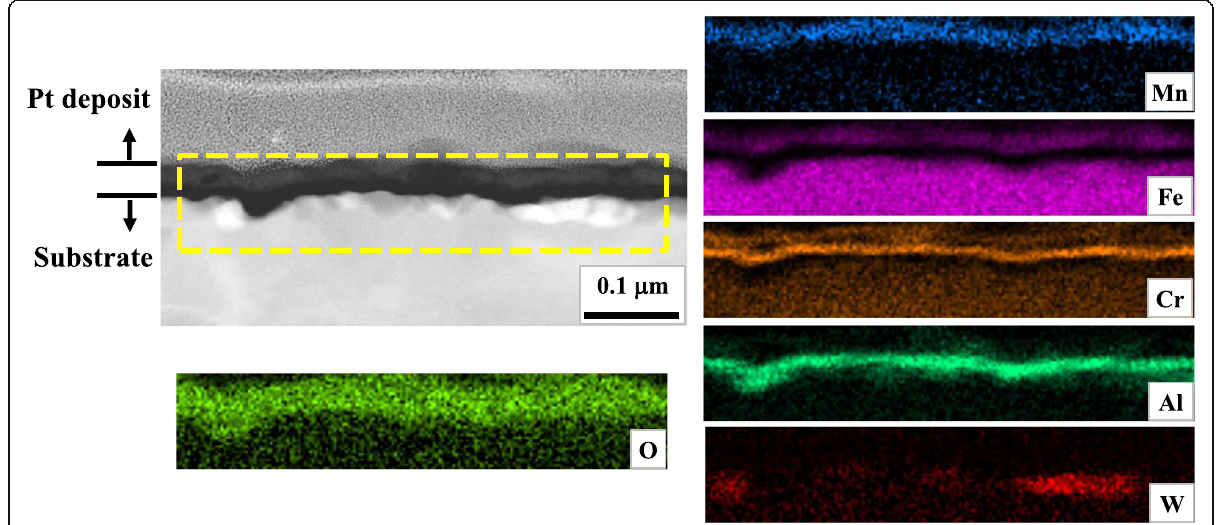
Fig. 3 Microstructure around the scale of W5 after 30 min of oxidation (STEI-DF and elemental maps by EDS within the broken box)